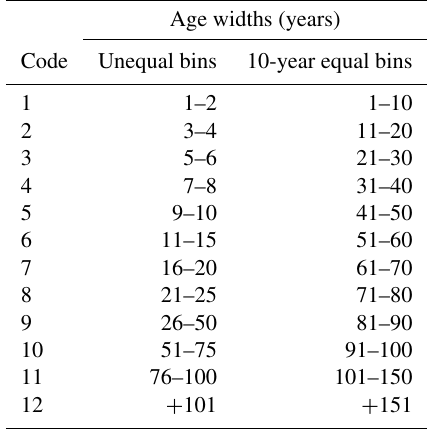
Table 1. Age-class widths corresponding to two different simulation age-class setups in LPJ-wsl v2.0. The age-class codes are referenced in